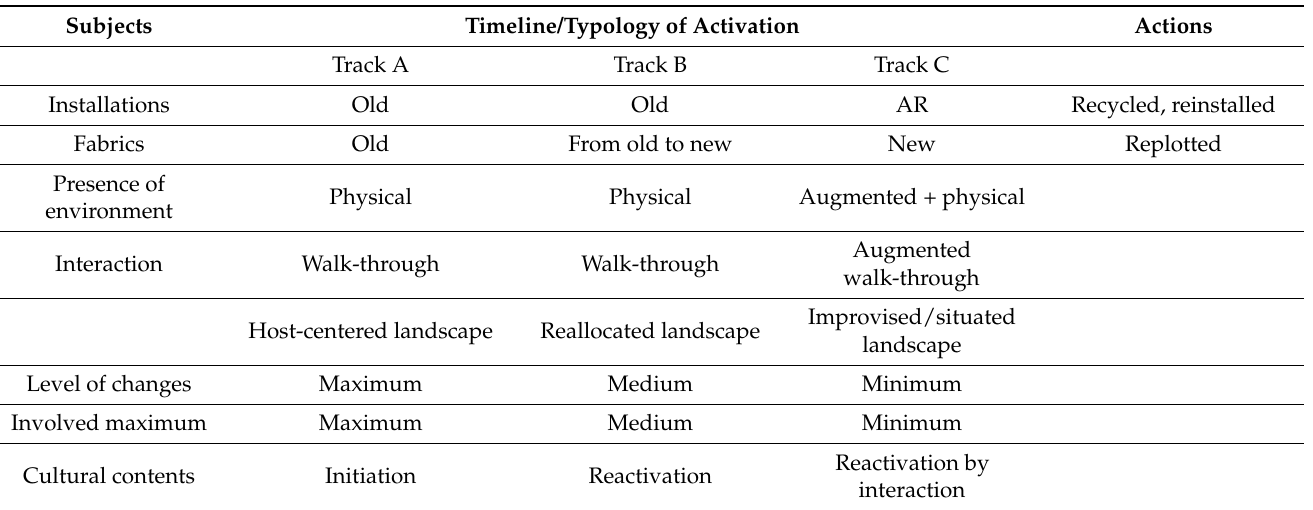
Table 3. Evolving loop in festival